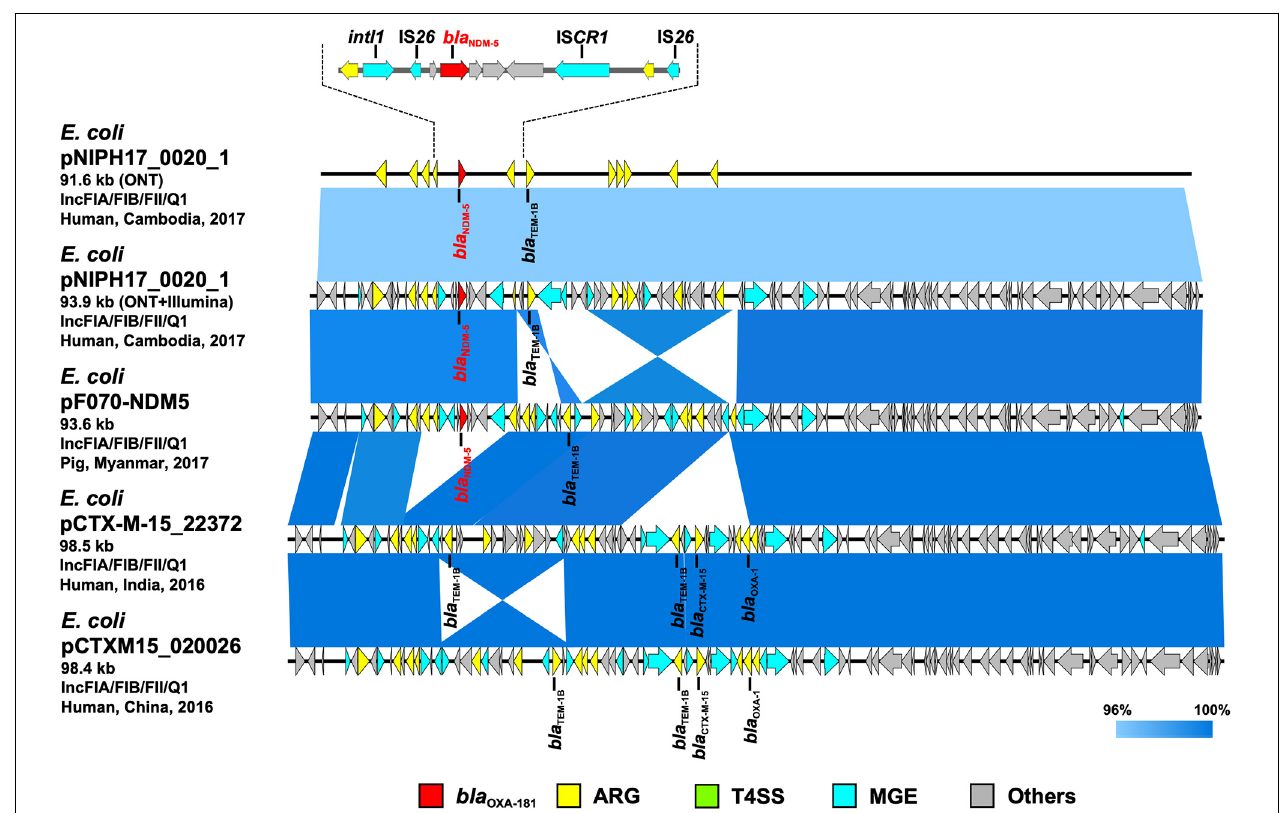
FIGURE 3 | Linear comparison of related plasmid sequences from Cambodia and other countries. E. coli pNIPH17_0020_1 with bla NDM − 5 (this study, accession no. LC483178), E. coli pF070-NDM5 with bla NDM − 5 (accession no. AP023238), E. coli pCTX-M-15_22372 with no bla NDM (accession no. CP040398), and E. coli pCTXM15_020026 with no bla NDM (accession no. CP034956) are shown. Regarding E. coli pNIPH17_0020_1, both the uncorrected sequence (from on-site ONT analysis) and corrected sequence (from subsequent ONT + Illumina analysis), and the detailed genetic structures around bla NDM − 5 are shown (upper). Red, yellow, green, blue, and gray arrows indicate carbapenemase gene ( bla NDM − 5 ), other AMR genes (ARG), type IV secretion system-associated genes involved in conjugation (T4SS), mobile gene elements (MGE), and other genes (Others), respectively. The colors in comparison of plasmids show percent